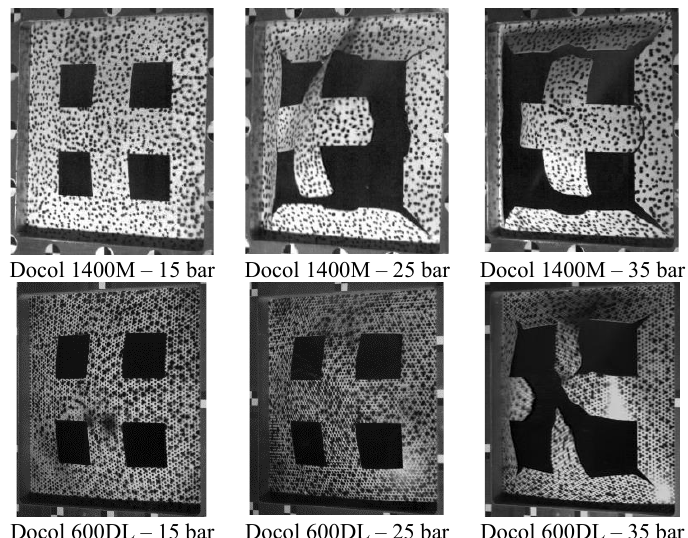
Fig. 3 . Experimental results for all six experiments. Both the material and firing pressure are indicated in the sub-caption of each image.